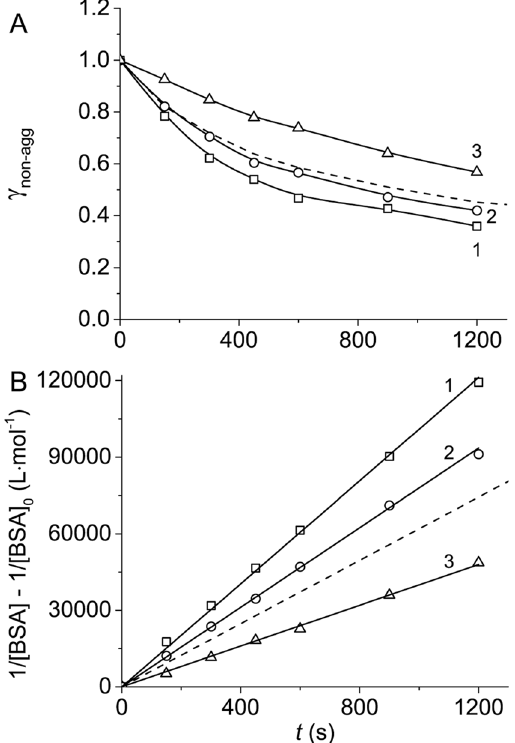
Figure 5. Kinetics of BSA aggregation in the presence of ArgEE registered by AF4. The dependences of the portion of non-aggregated protein ( γ non-agg ) on time ( A ) and the linear anamorphoses constructed in the coordinates {(1/[BSA] − 1/[BSA] 0 ); t } ( B ) at the following concentrations of ArgEE: 50 (1), 100 (2) and 700 mM (3). The dotted lines on panels A and B correspond to the data obtained in the absence of chemical chaperones.